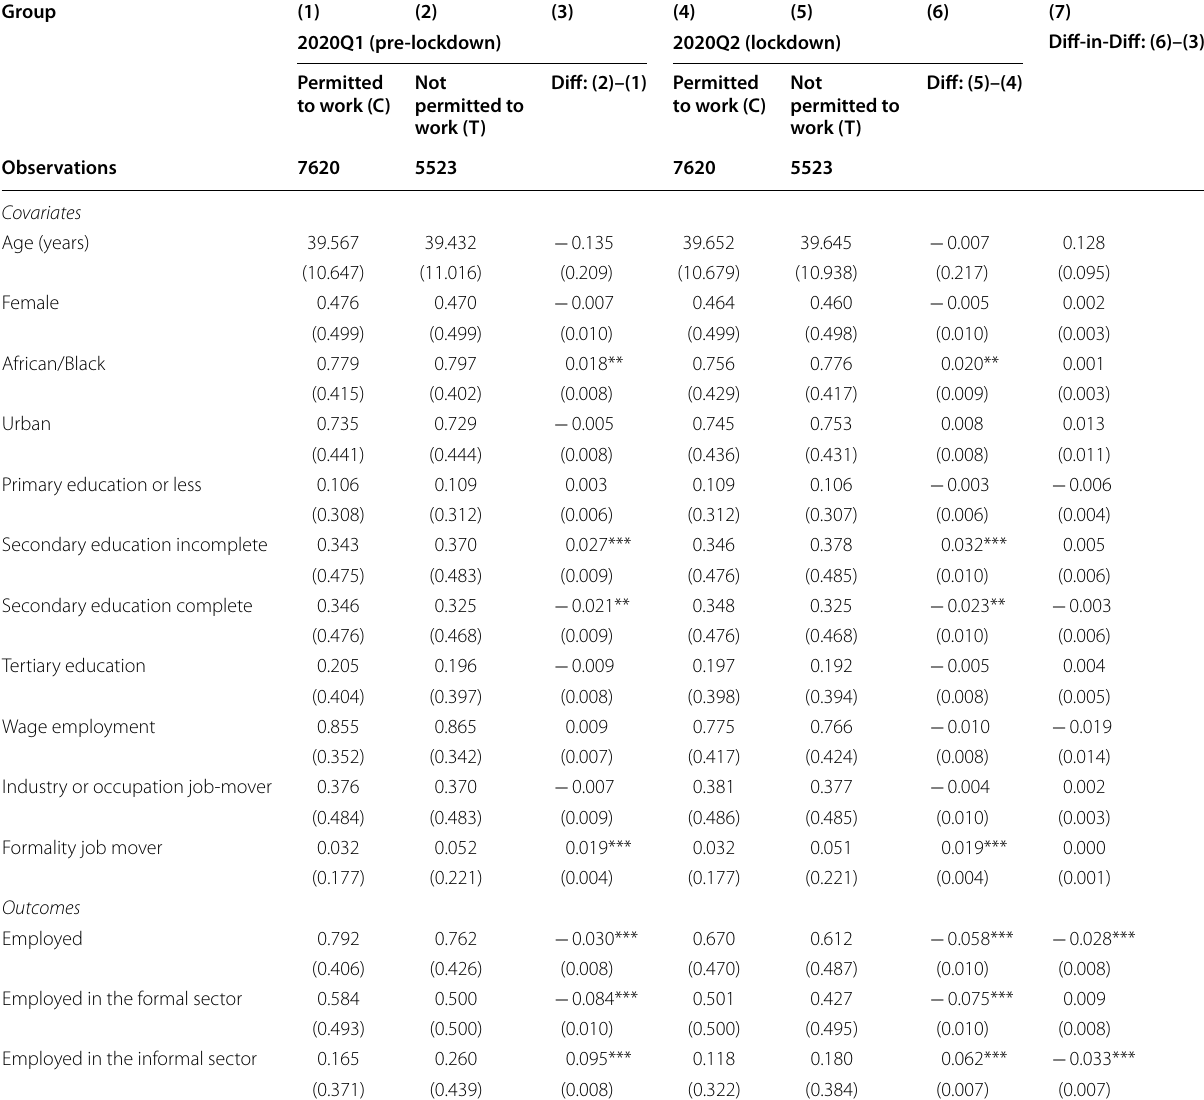
Table 2 Covariate balance table, by treatment status and period. Author’s own calculations. Source : QLFS 2020Q1 and